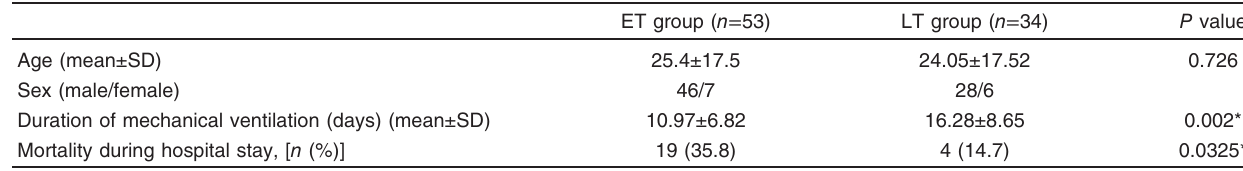
ET, early tracheostomy; LT, late tracheostomy. * P < 0.05 (statistically significant).